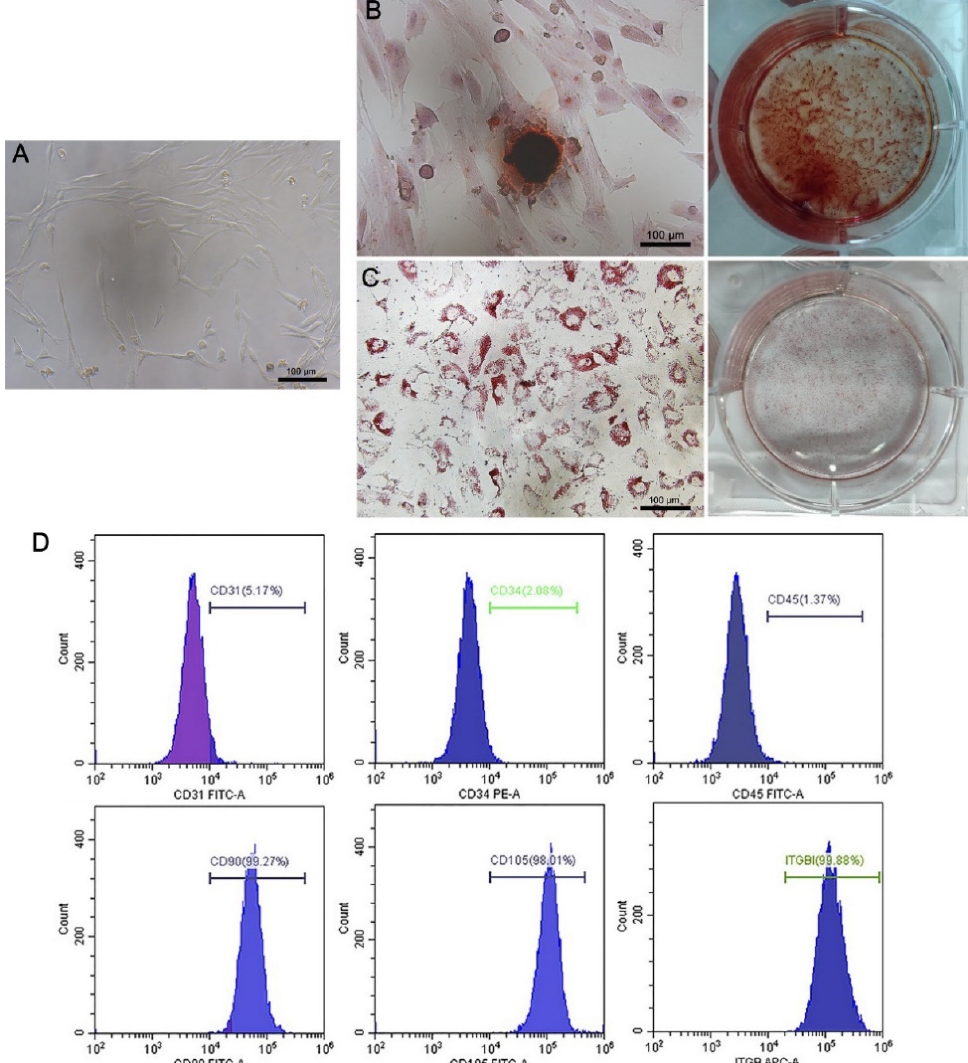
Figure 1. Characteristics of MSCs isolated from canine bone marrow. ( A ) The morphology of third-generation canine bone marrow-derived mesenchymal stem cells (cBMSCs) cultured at 48 h was observed using a light microscope; scale bars = 100 μ m. ( B ) Alizarin Red S stained calcium deposition; scale bars = 100 μ m. ( C ) Oil Red O staining was used to observe the lipid droplet accumulation; scale bars = 100 μ m. ( D ) The 3rd passage cBMSCs were stained with FITC, PE, or APC fluorescent-labeled antibodies and analyzed using flow cytometry.